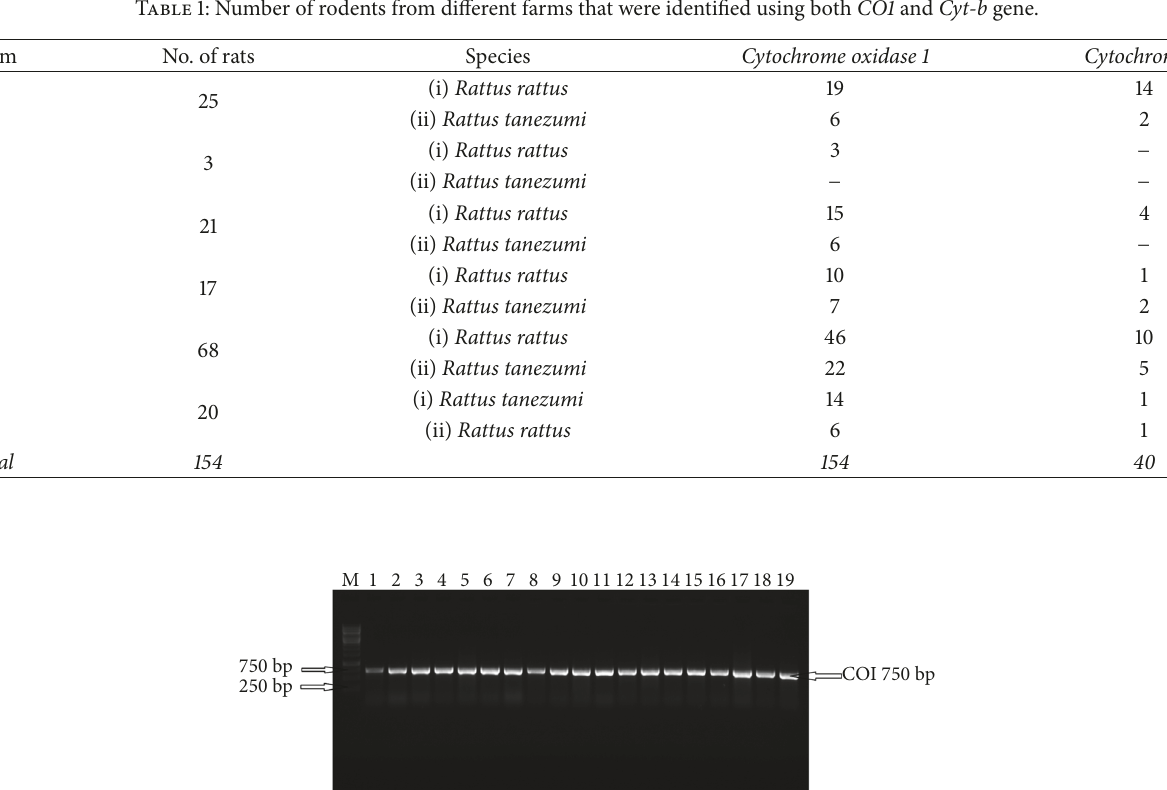
Table 1: Number of rodents from different farms that were identified using both CO1 and Cyt-b gene.